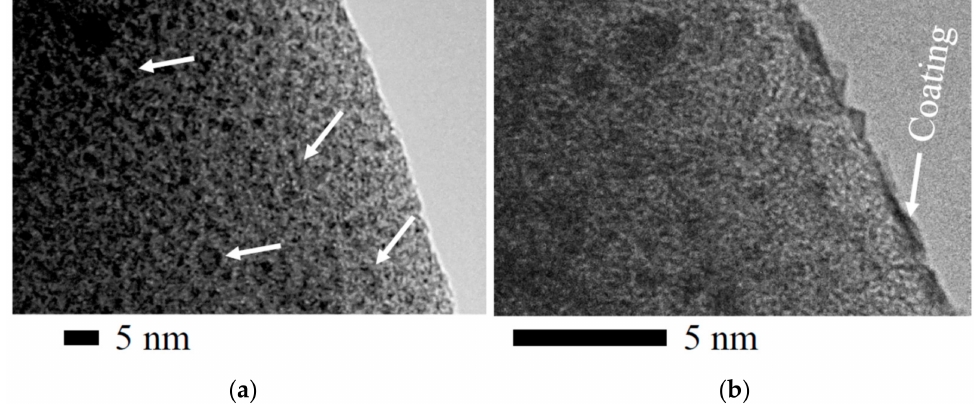
Figure 6. TEM images of an Au@SiO 2 bionanocomposite sample taken at two different points. ( a ) Arrows show contacting or merged nanoparticles located in adjacent pores inside the silica matrix. ( b ) The arrow shows the coating formed on the surface of the silica. The bionanocomposite was prepared by dipping TA@SiO 2 containing 0.1 wt.% TA into a solution with 0.2 mM HAuCl 4 . Polyphenol was washed out after the